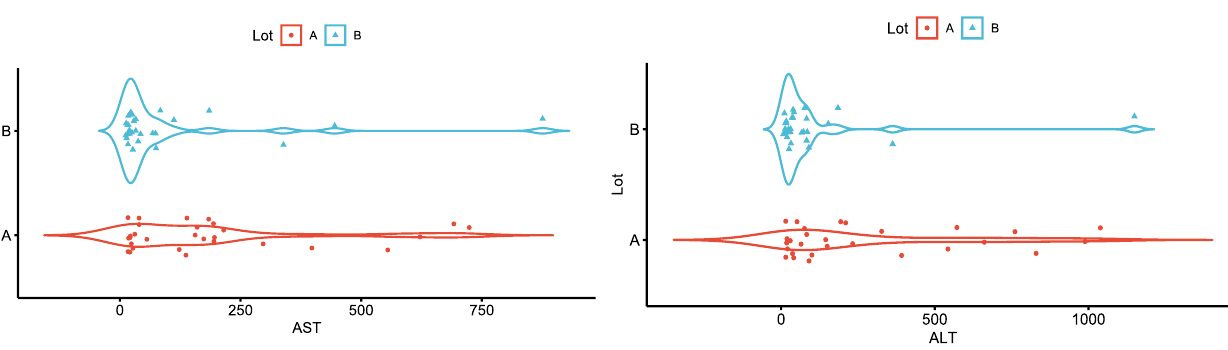
Figure 7. Median AST and ALT values in patients with pancreatic cancer (group A) vs. chronic pancreatitis (group B).